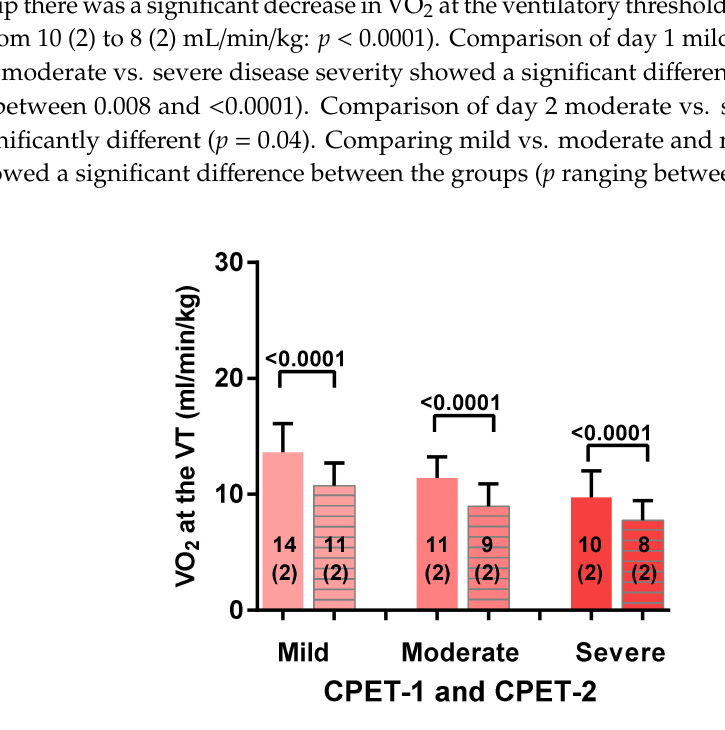
Figure 2. Oxygen consumption at the ventilatory threshold for both CPET-1 and CPET-2 for mild, moderate and severe ME / CFS patients. CPET: cardiopulmonary exercise test; VO 2 : oxygen consumption; VT: ventilatory (or anaerobic) threshold. For between group comparisons see the result section. CPET-1 is presented by a solid bar and CPET-2 is represented by a lined